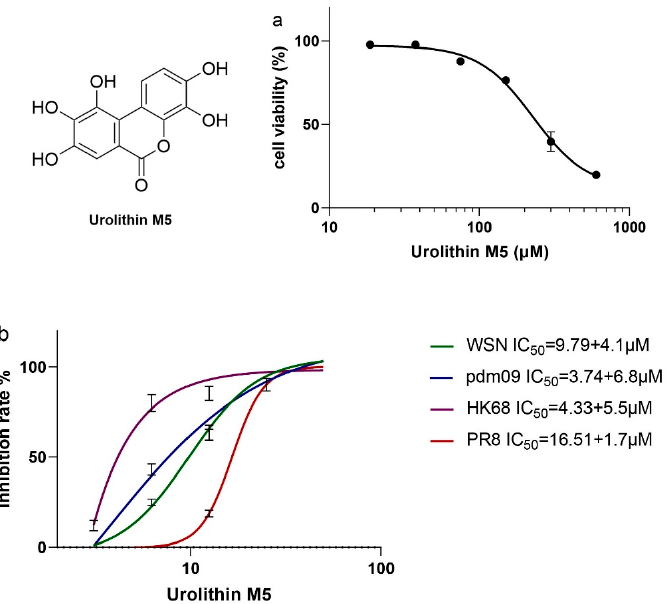
Figure 1. In vitro activities of urolithin M5 were identified by plaque reduction assay. Urolithin M5 inhibited four IAV strains in a dose-dependent manner, and CC 50 ( a ) and IC 50 ( b ) values were cal- culated by Graphpad Prism